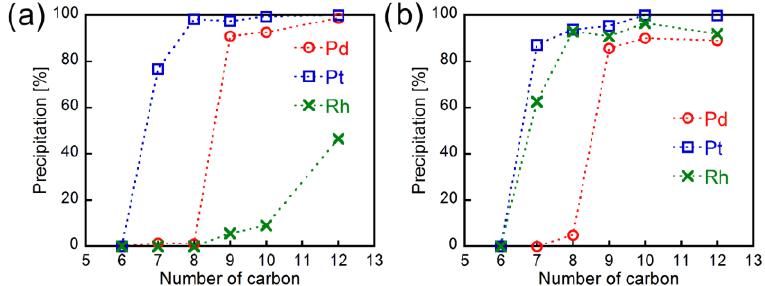
Figure 2. Relationship between metal precipitation and alkyl chain length of the amine in ( a ) 1.0 M HCl solutions and ( b ) 6.0 M HCl solutions (metal: 1 mM each, amine: 50 mM, 30 min of shaking).